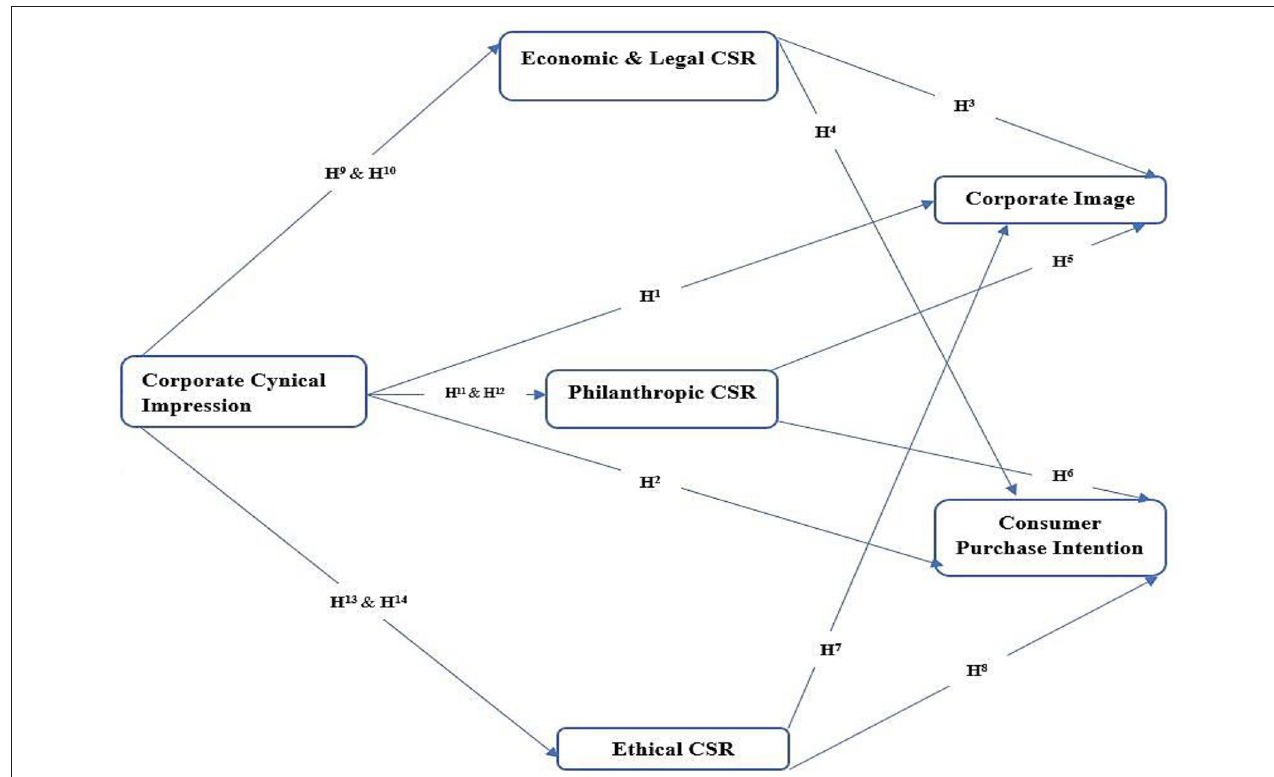
FIGURE 1 | Theoretical